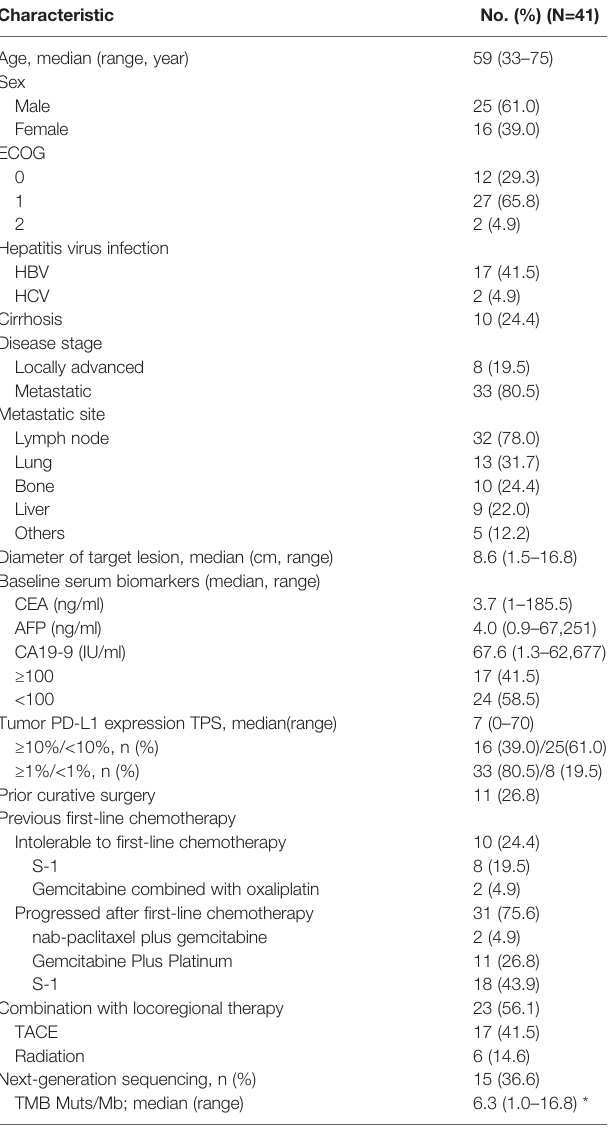
TABLE 1 | Baseline characteristics and